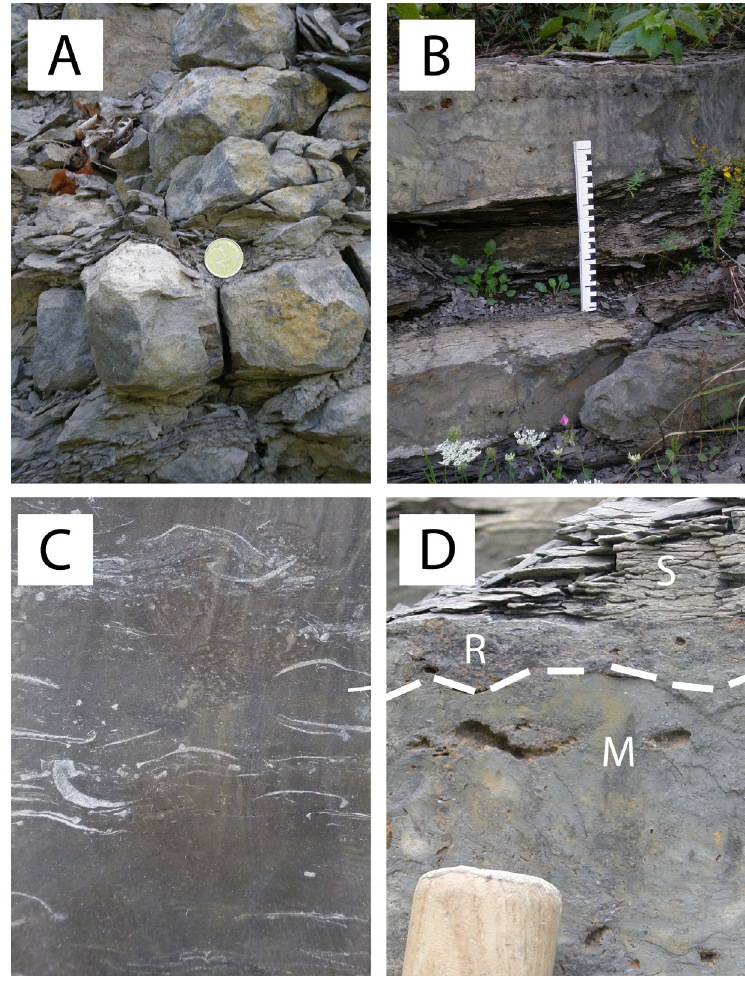
Figure 10. Facies partitioning in the Eastview Member, Lindsay Formation, Locality